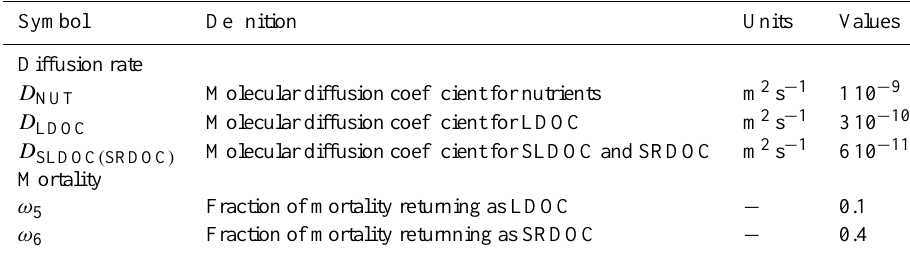
Table 3. Miscellaneous model